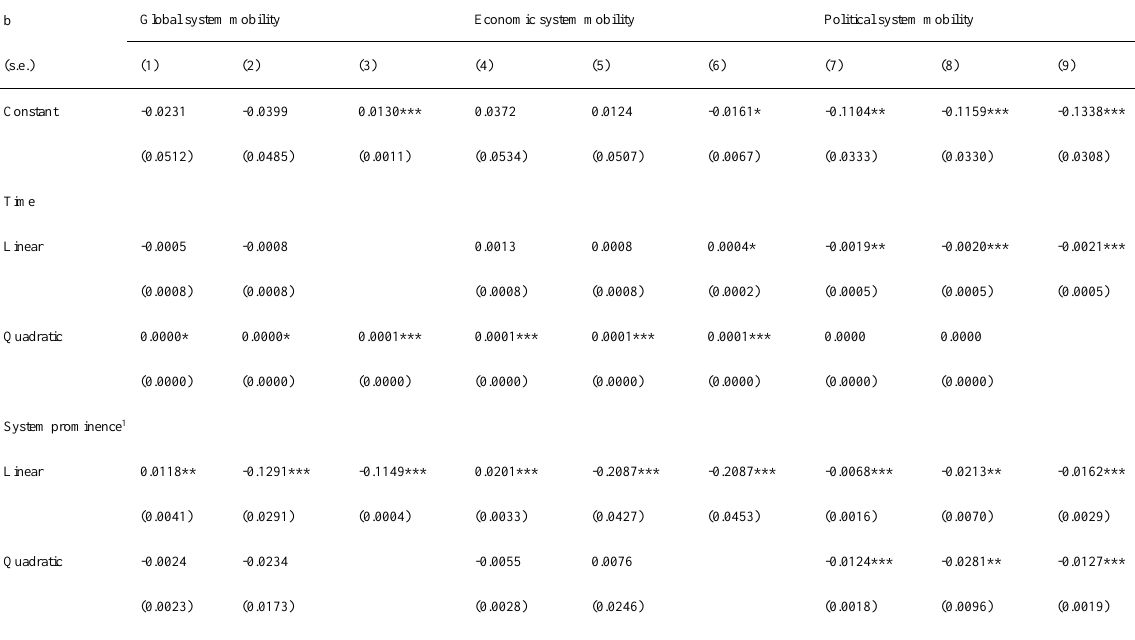
Table 4: Random-Effects GLS Regression Results for Change in Global, Economic and Political System Prominence,